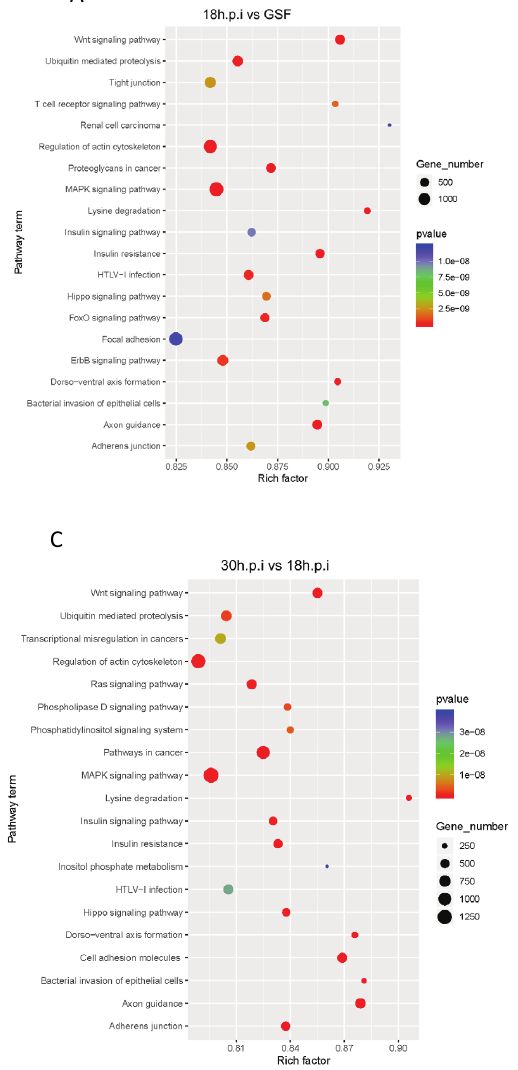
Figure 3. KEGG enrichment analyses of DE miRNAs in 18h.p.i vs. GSF, 30h.p.i vs. GSF and 30h.p.i vs. 18h.p.i. ( A ) Top 20 significantly enriched KEGG pathways of DE miRNAs in 18h.p.i vs. GSF. ( B ) Top 20 significantly enriched KEGG pathways of DE miRNAs in 30h.p.i vs. GSF. ( C ) Top 20 significantly enriched KEGG pathways of DE miRNAs in 30h.p.i vs. 18h.p.i.